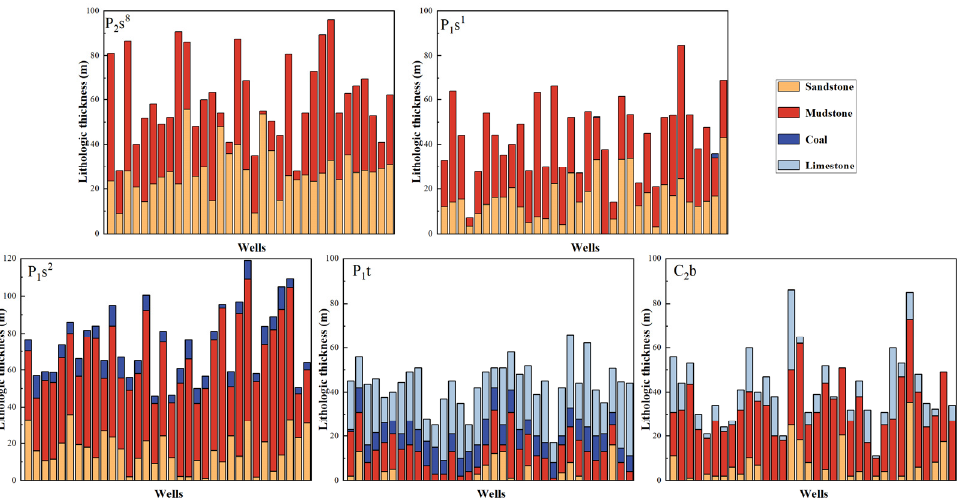
Figure 2. The characteristics of lithology development in each stratum in the study